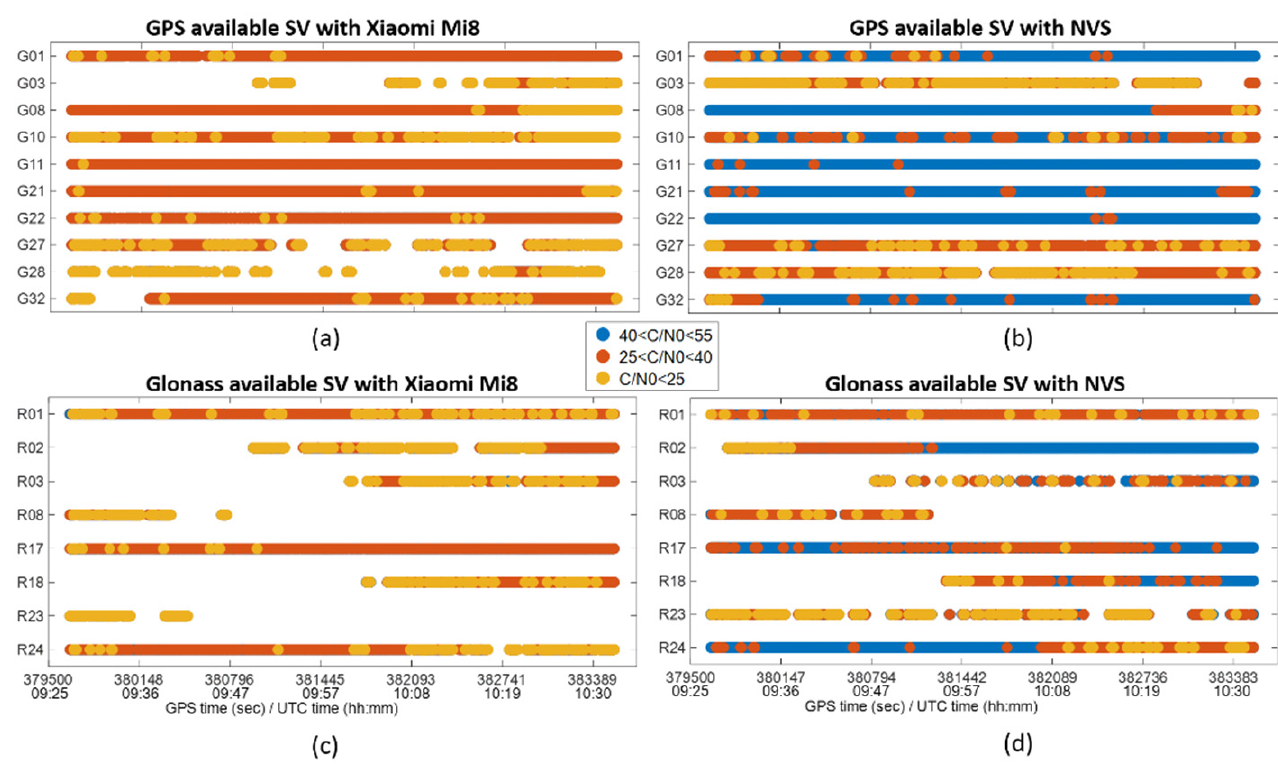
Figure 4. Available satellites and C/N0. Frame ( a ) refers to GPS satellites available from Xiaomi Mi8. Frame ( b ) refers to GPS satellites available from NVS. Frame ( c ) refers to Glonass satellites available from Xiaomi Mi8. Frame ( d ) refers to Glonass satellites available from NVS.